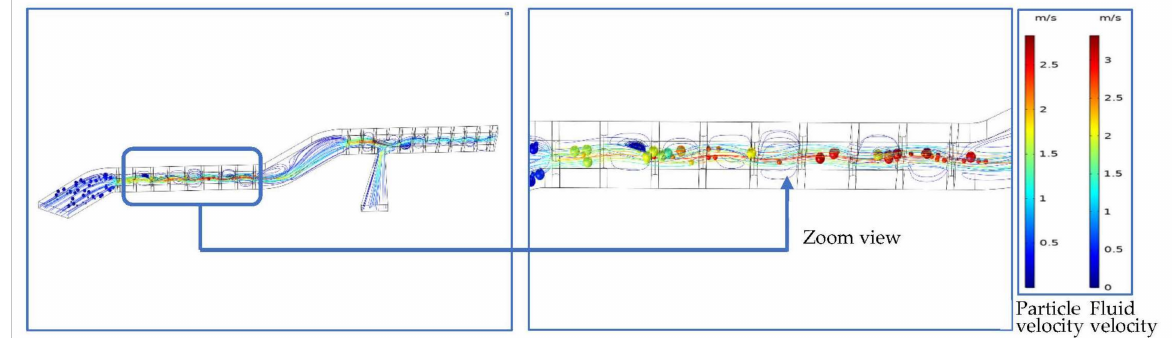
Figure 14. 3D view of cilia wall microchips at 0.004 s.